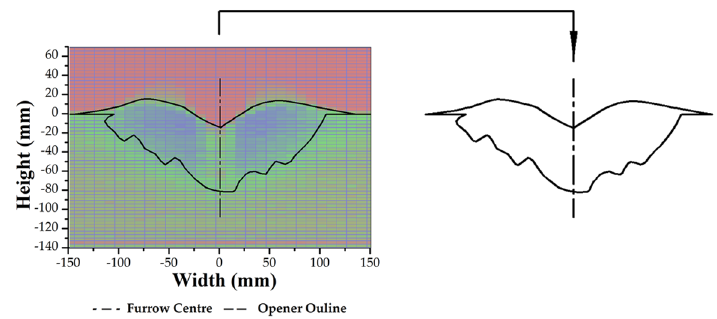
Figure 8. Construction of furrow profile by porosity grid.